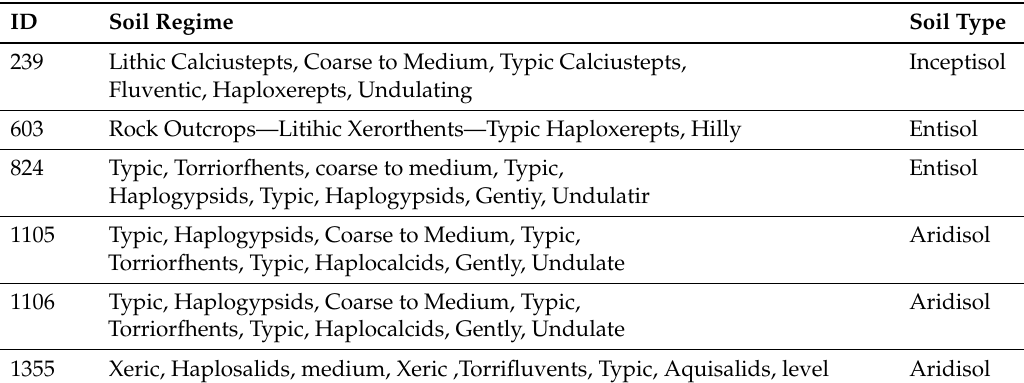
Table 2. A frame of the attribute table of soil type and soil regime map in the geospatial database.